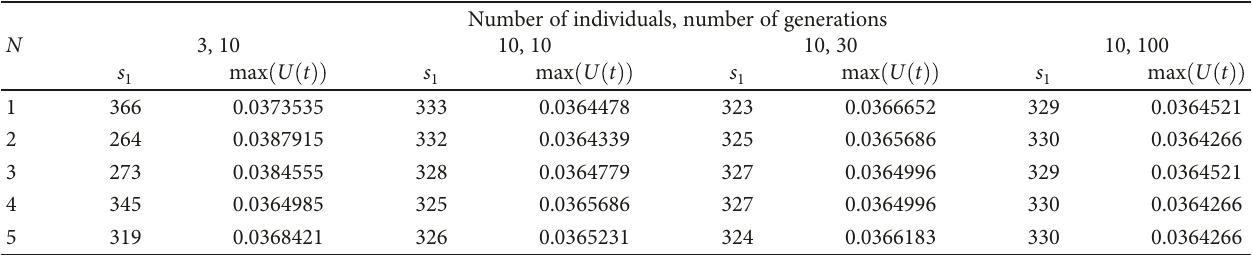
Table 5: Results of the GA optimization of s MF